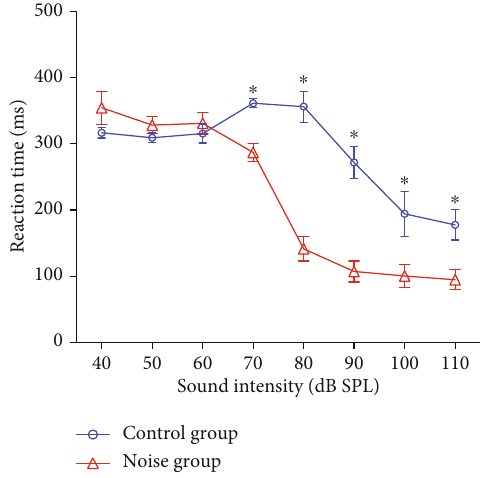
Figure 2: The reaction time-intensity functions measured from the rats in the control group ( n = 4 ) and the noise group ( n = 4 ) using narrow-band noise centered at 2 kHz (40-110dB SPL, 10dB step). At high intensity sound levels ( > 70dB SPL), the reaction time in the noise group was signi fi cantly shorter than that in the control group (Student ’ s t -test, P < 0 : 05 ), suggesting an increased loudness